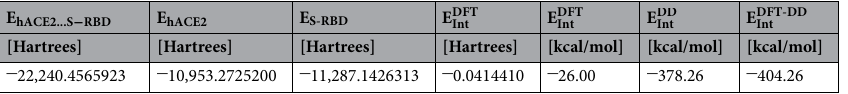
b a . DFT b Distance-dependent